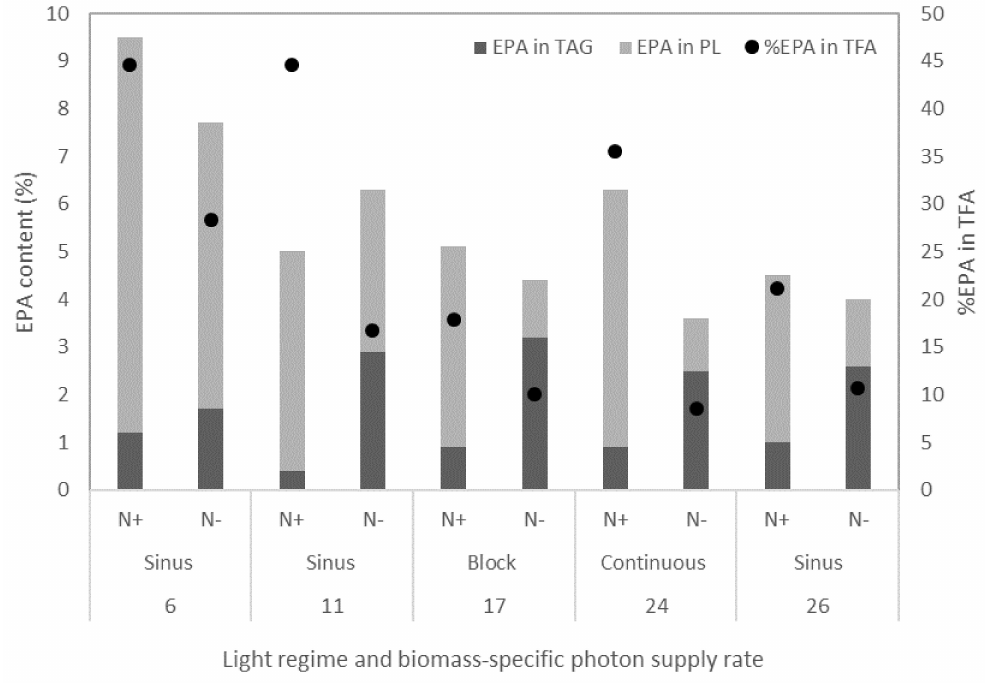
Figure 5. EPA content in TAG and polar lipids (PL) expressed as a percentage of dry weight and the EPA percentage of the total fatty acids (TFA) for the different initial biomass-specific photon supply rates and light regimes. Results are shown at the start of the nitrogen starvation phase (N+) and